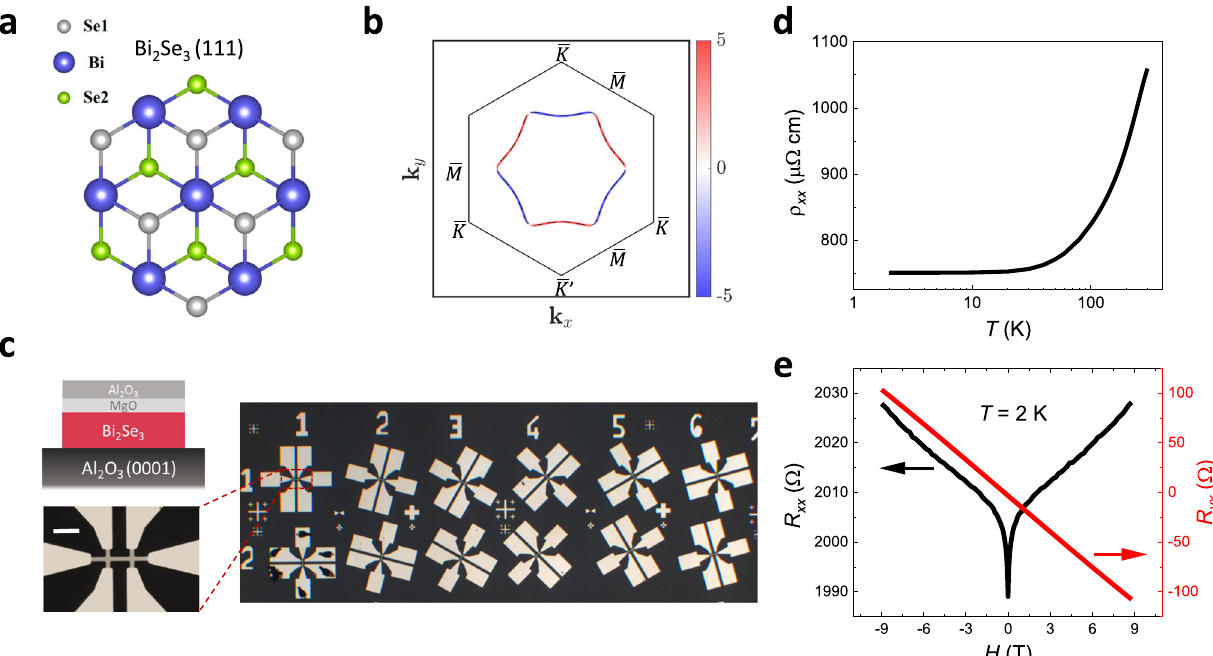
Fig. 1 Crystal structure, Berry curvature distribution, and characterizations of Bi 2 Se 3 . a Crystal structure of Bi 2 Se 3 . From top view along the z -direction of Bi 2 Se 3 (111) surface, the triangle lattice in one quintuple layer has three different positions, denoted as Se1, Bi, and Se2. b Schematic of Berry curvature distribution on the Fermi surface (FS) of TSS. The colored hexagon represents the hexagonally warped FS. The blue and red color contours indicate the negative and positive Berry curvature in an arbitrary unit. The black hexagon represents the surface Brillouin zone. c Schematic of the sample structure and optical image of Hall bar devices with the current channel along different directions. The inset shows magni fi ed view of a device. The scale bar is 100 μ m. d Temperature dependence of the longitudinal resistivity ( ρ xx ) under zero magnetic fi eld in 20 QL Bi 2 Se 3 . e Magnetic fi eld dependence of the longitudinal resistance ( R xx ) and Hall resistance ( R yx ) at 2 K in 20 QL Bi 2 Se 3